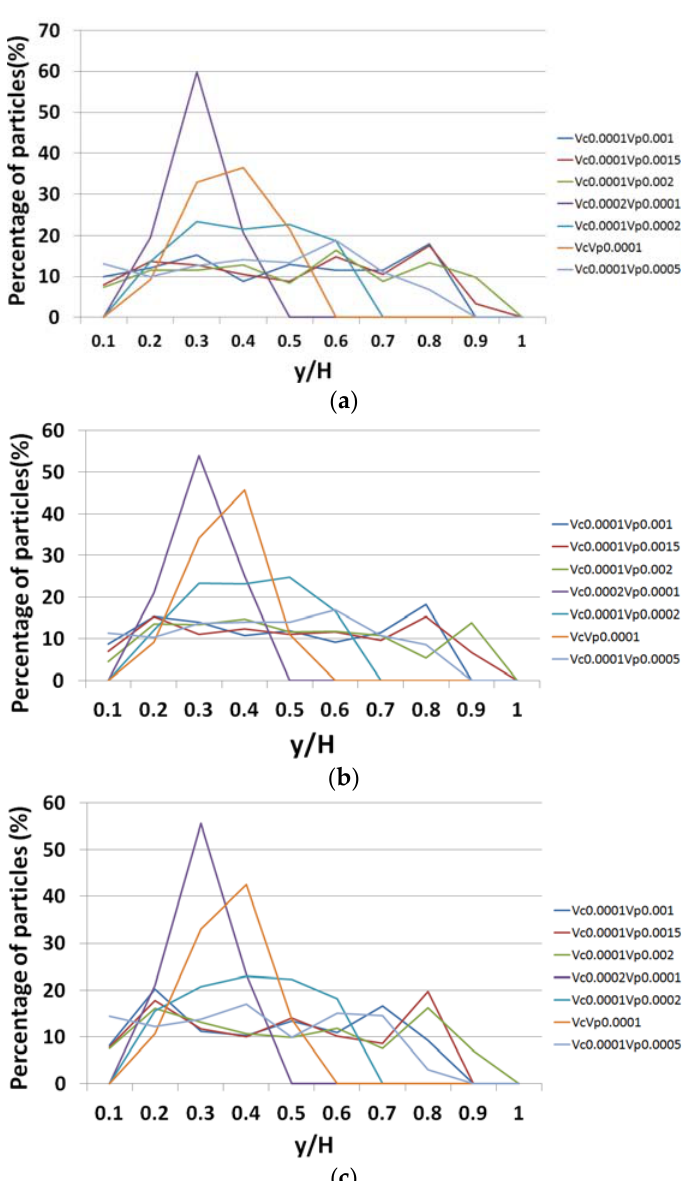
Figure 4. Streamlines ( left ) and snapshots of the particles locations ( right ) for the case of (cid:3023)(cid:3043) and ( a ) θ = 30°, ( b ) θ = 45°, and ( c ) θ = 60°.